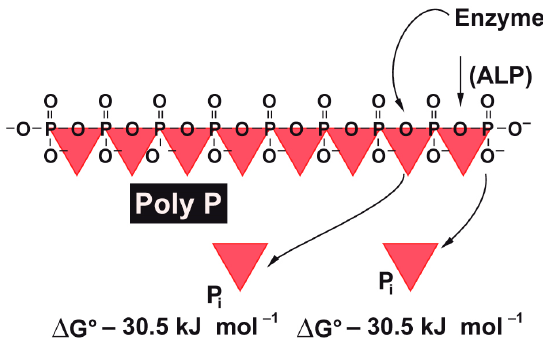
Figure 1. The linear inorganic polyphosphate (poly P) is composed of many phosphate (Pi) residues which are linked by high-energy phosphoanhydride bonds. If those “high-energy” phosphate bonds are cleaved, e.g., by enzymes (like the alkaline phosphatase), the “stored” energy is released ( ∆ G —30.5 kJ · mol − 1 ).